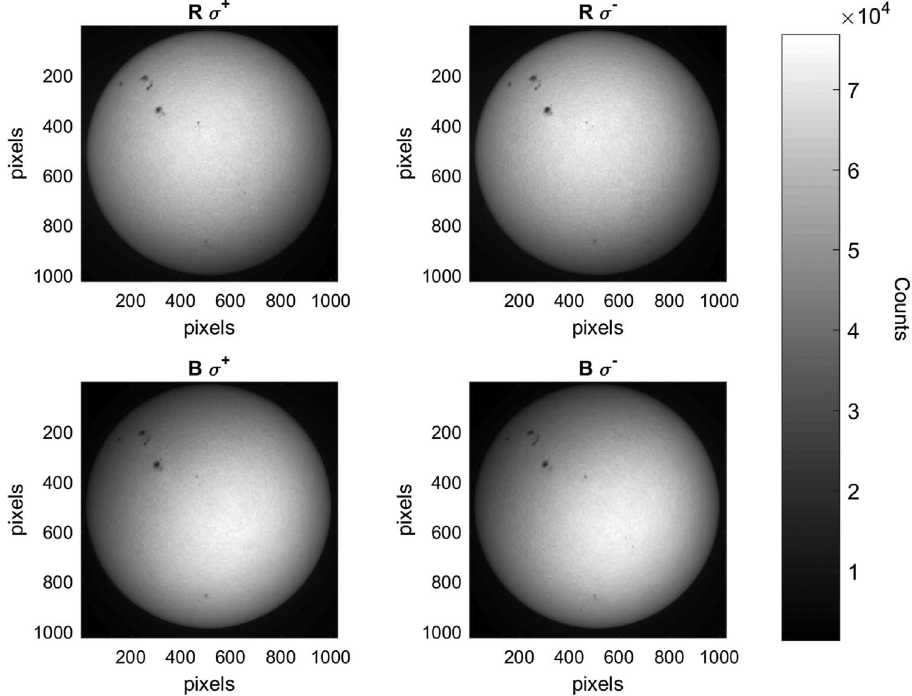
Fig. 3. Sample of a raw (Level 0) four image set (R r + , R r (cid:1) , B r + , B r (cid:1) ) acquired in the K channel. The pixel scale is ~2 arcsec/pixel.